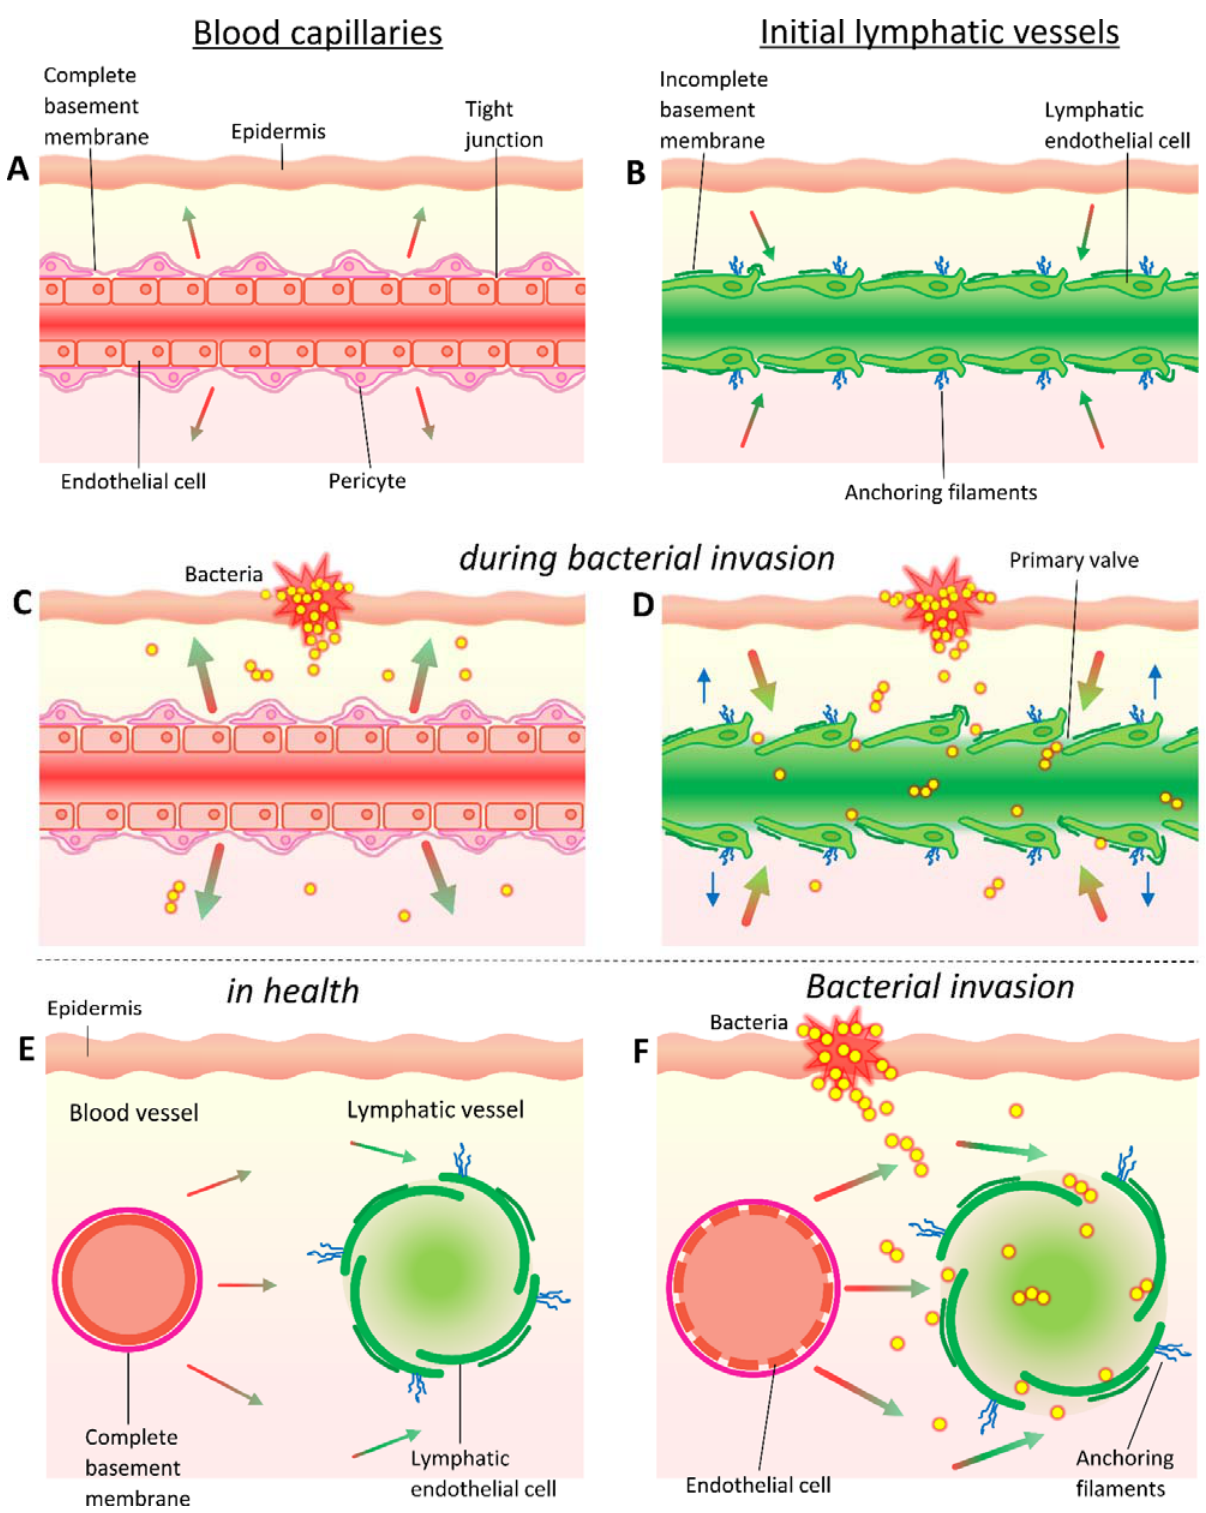
Figure 3. Fluid exchange and bacterial uptake in the vasculature. In tissue, fluid leaks from ( A , C ) vascular capillaries and venules are characterised by tight junctions between endothelial cells, a complete basement membrane, presence of pericytes, and occasional smooth muscle fibres. By contrast, ( B , D ) the initial lymphatics have an incomplete basement membrane, lack smooth muscle, and have buttonlike wide gap junctions between endothelial cells, as well as anchoring filaments that are tethered to surrounding tissue. Though small molecules ( ≤ 10 nm diameter) are preferentially absorbed from the interstitial space into the blood capillaries rather than lymphatic